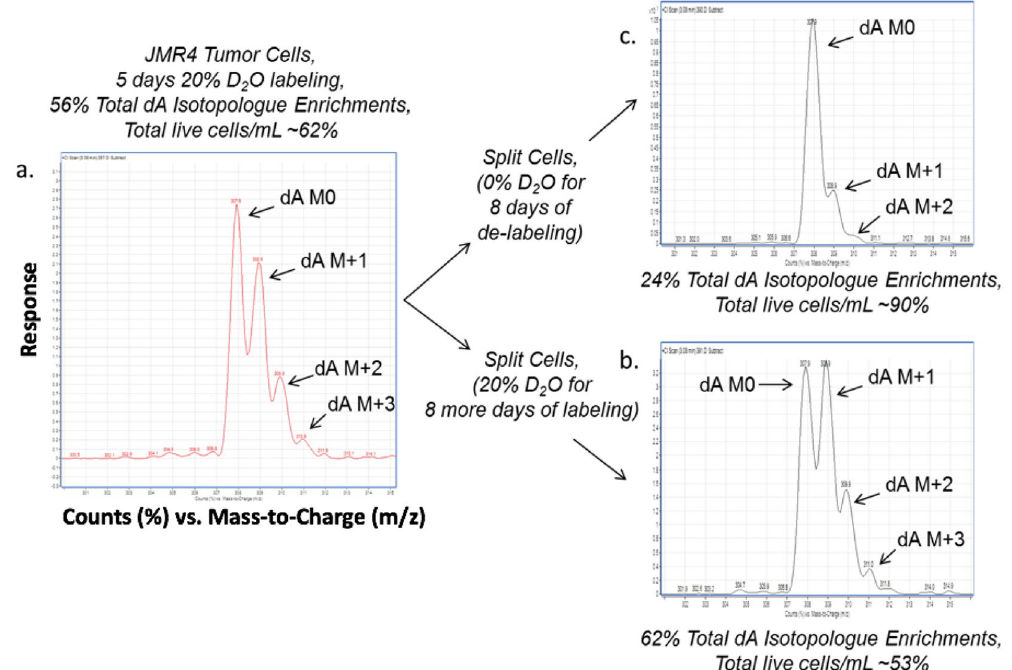
Figure 4. Mouse thymus tumor cells incubated using 20% D 2 O for dA enrichment study. Mouse thymus tumor cells were incubated in cell media using incubator conditions of 10% CO 2 , > 95% relative humidity and 37 °C. The tumor cells were dosed using 20% D 2 O (v/v) and incubated for 5 days; afterwards the cells were split into fresh media (with and without 20% D 2 O) for an additional 8-day incubation. ( a ) Using a 20% D 2 O dosing, the tumor cell DNA base deoxyadenosine (dA) demonstrated significant deuterium enrichment into the dA isotopologues (~56% total dA enrichment), which negatively affected cell proliferation (~62% cell viability). ( b ) With a longer incubation period (13 days total), measurement of the cell counts and % cell viability using 20% D 2 O revealed an increase in total dA isotopologue enrichments (~62%) and further decrease in cell proliferation (~53% cell viability). ( c ) The tumor cells split into fresh media without D 2 O proliferated like control (0% D 2 O) mouse thymus tumor cells (total dA isotopologue level (~24%) and cell viability